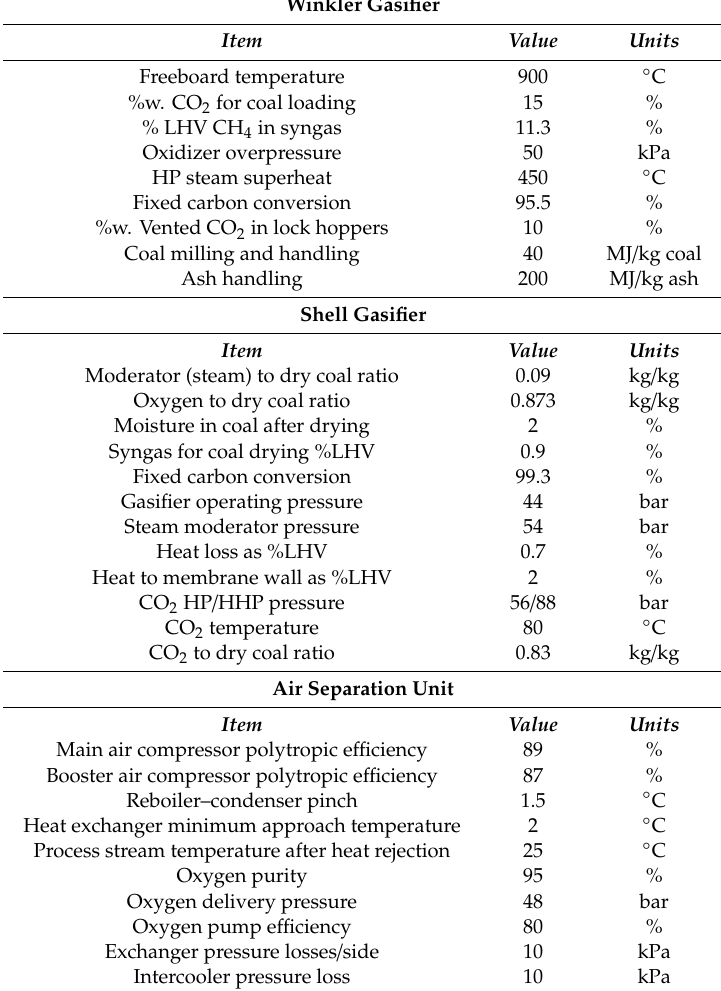
Table A1. Gasification island assumptions.